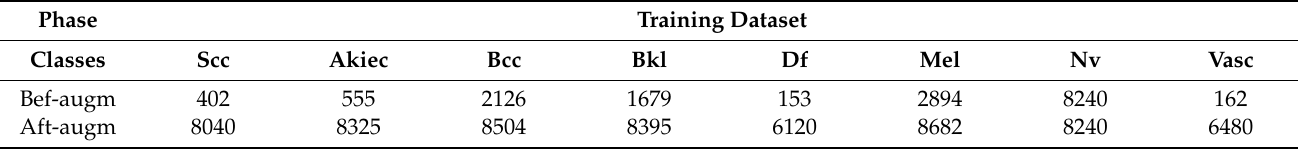
Table 2. Balancing dermoscopic image of ISIC 2019 dataset of skin